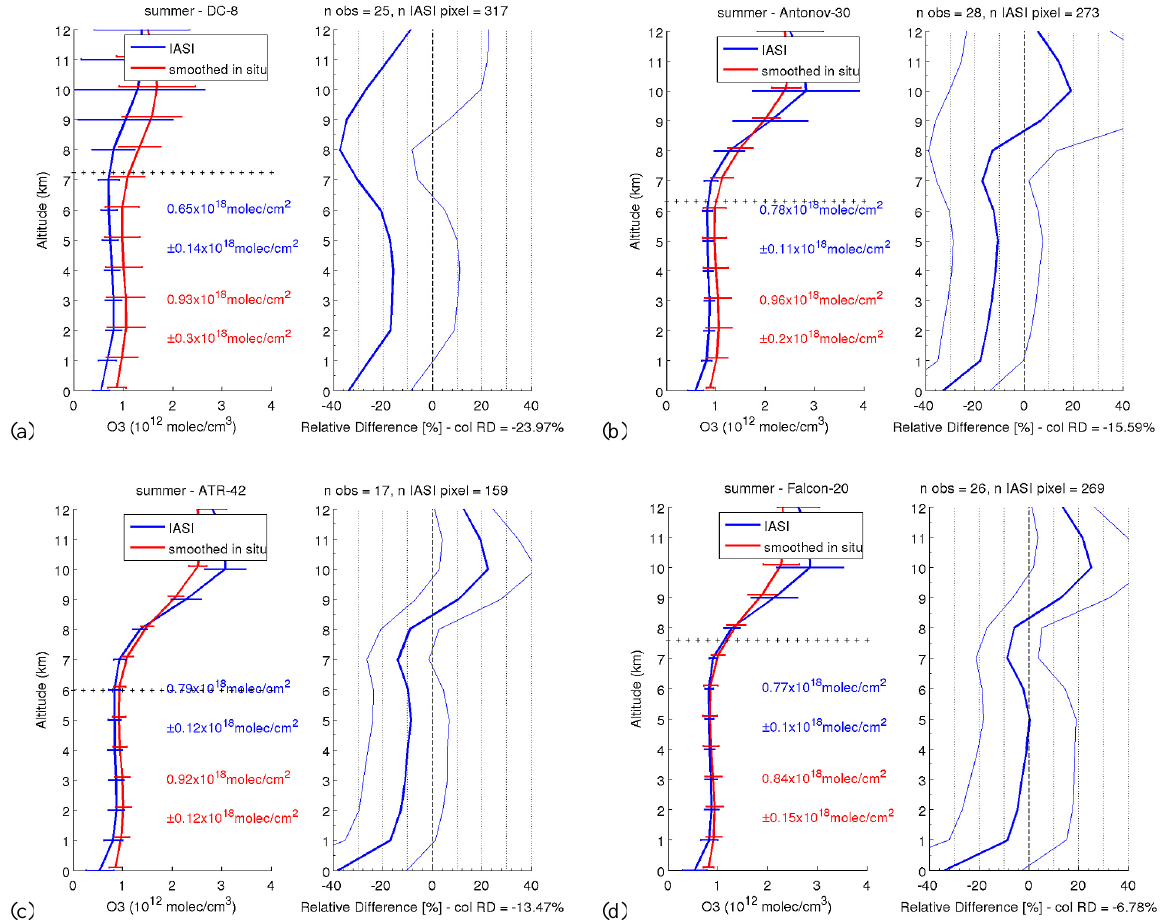
Fig. 7. Same as Fig. 6 for the aircraft involved in the summer campaigns: DC-8 (a) , Antonov-30 (b) , ATR-42 (c) , Falcon-20 (d) . The mean ECMWF dynamical tropopause is at 11.3, 9.5, 8.7 and 8.6km,